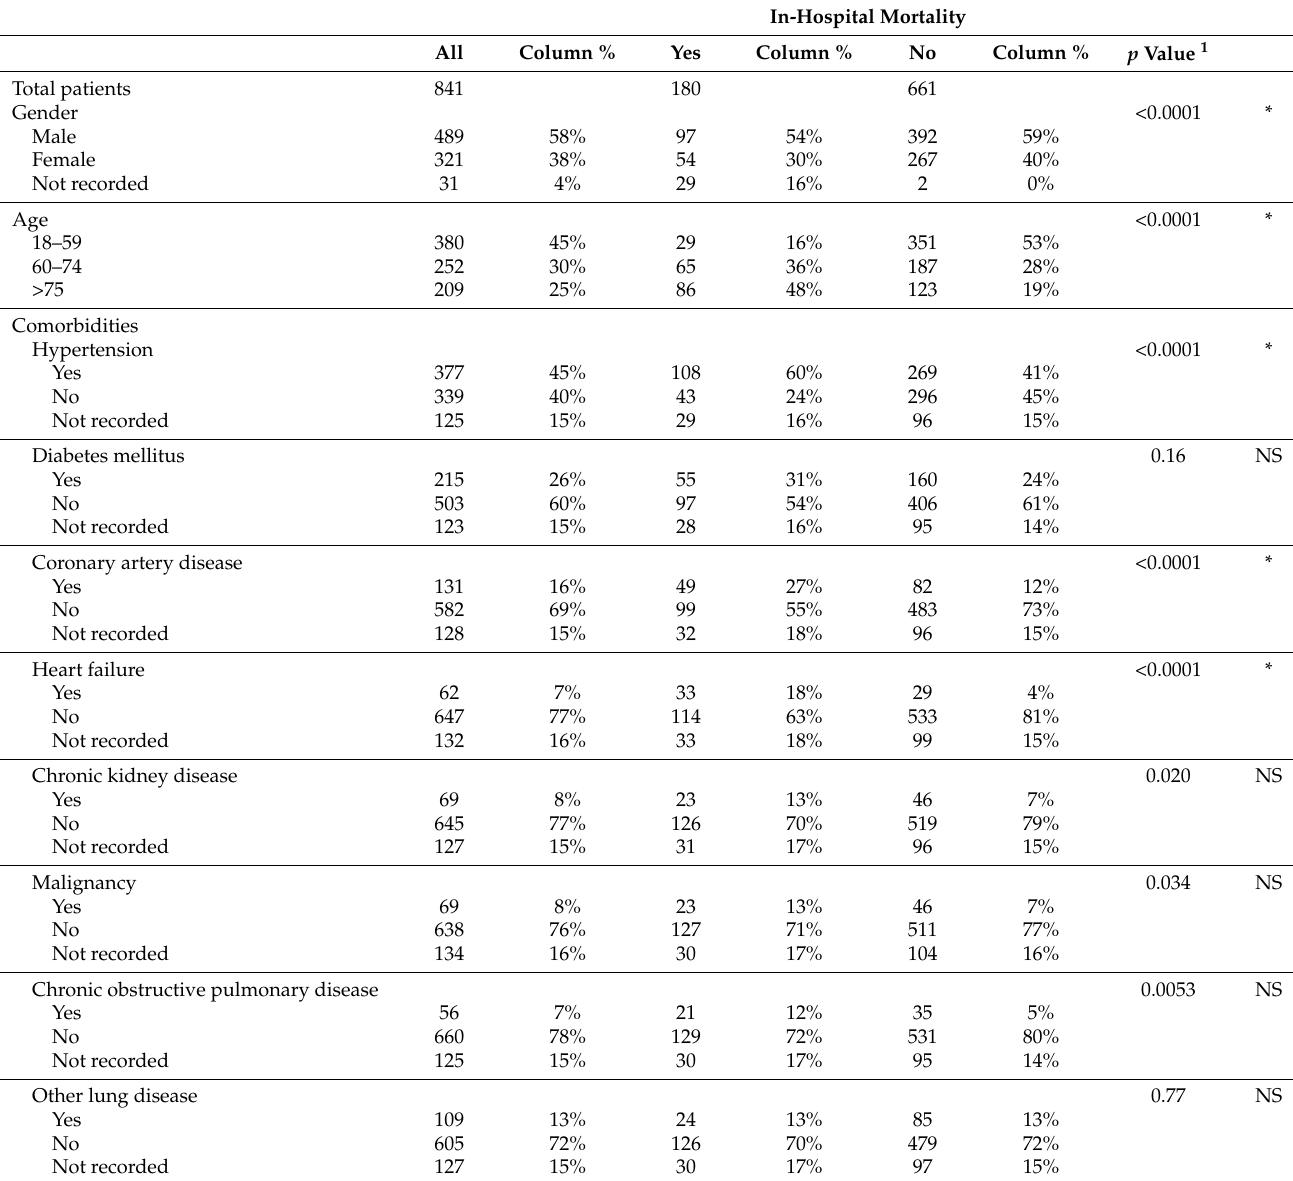
Table 2. Characteristics of patients included in the